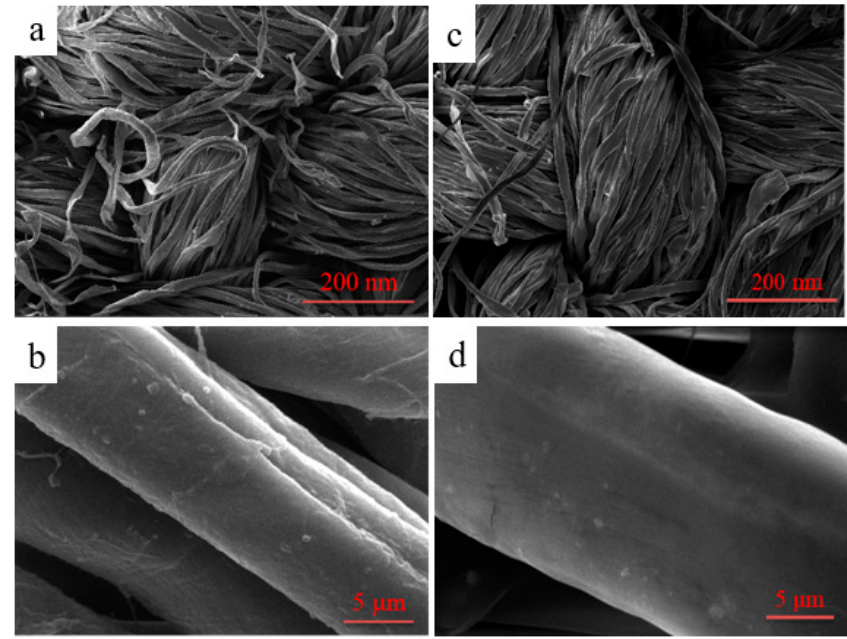
Figure 12. SEM images of un fi nished ( a , b ) and fi nished co tt on fi bers ( c , d ).